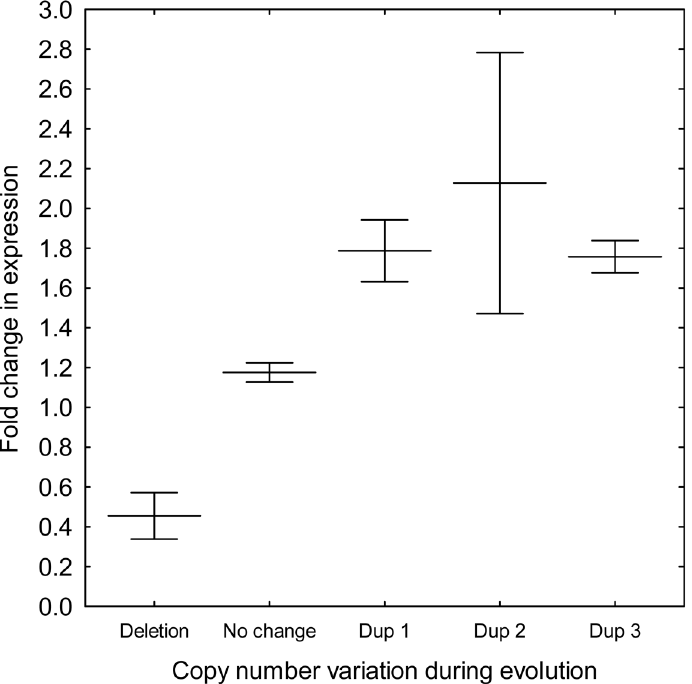
Fig 2. Gene expression changes as a function of copy number variation. The figure shows mRNA expression fold change in evolved line 1 relative to the corresponding ancestor. As expected, loss of a small part of one copy of chromosome V (deletion) leads to reduced mRNA levels of the corresponding genes, while the opposite is true for genes carried on duplicated segments of VII (Dup1), IX (Dup2) and XIII (Dup3). Center lines show mean ± 95% confidence interval. Fold change differences across the three main categories (duplication, deletion, and no change) are highly significant ( t test, p < 10 − 6 for each comparison).